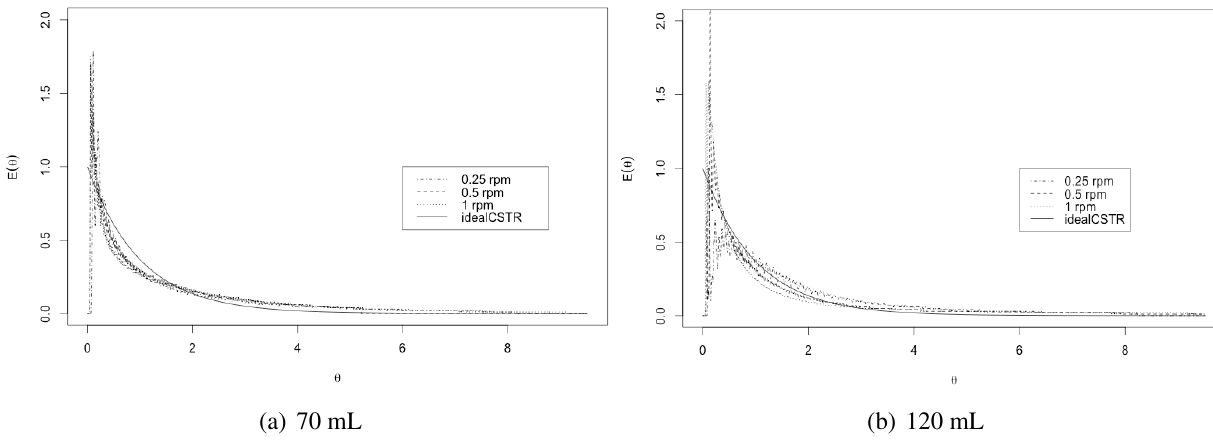
Figure 2. Residence time distribution (RTD) in Z ® RP 2000H bioreactor depending on rotation speed of the reactor bed (0.25, 0.5, 1 rpm) and medium volume ( a ) 70 mL and ( b ) 120 mL; ( n = 1). RTD for ideal CSTR is plotted for comparison